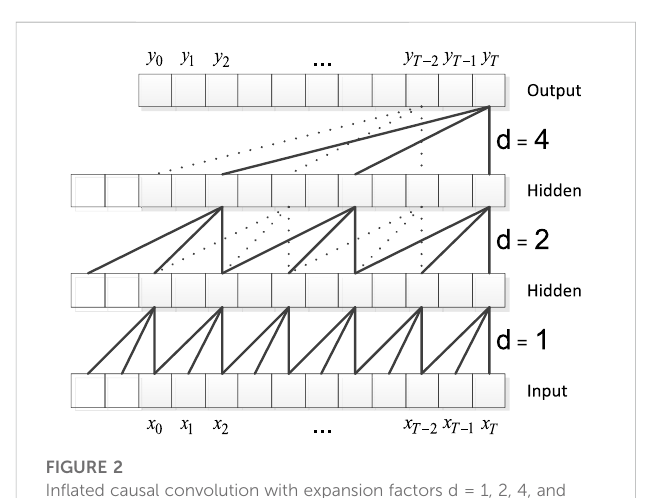
FIGURE 2 In fl ated causal convolution with expansion factors d = 1, 2, 4, and fi lter size k =